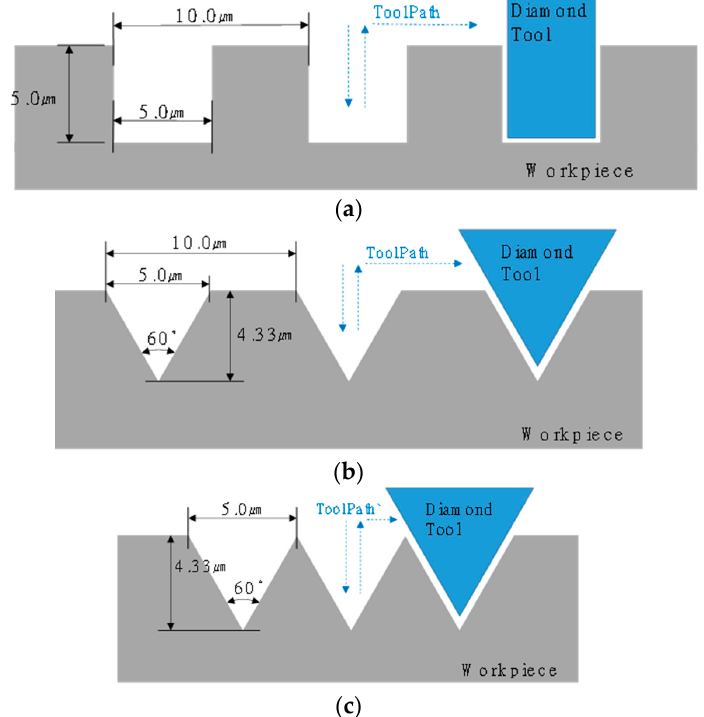
Figure 2. Three shapes of microstructural patterns: ( a ) with rectangular cross-sections; ( b ) trapezoidal cross-sections; ( c ) triangular cross-sections.